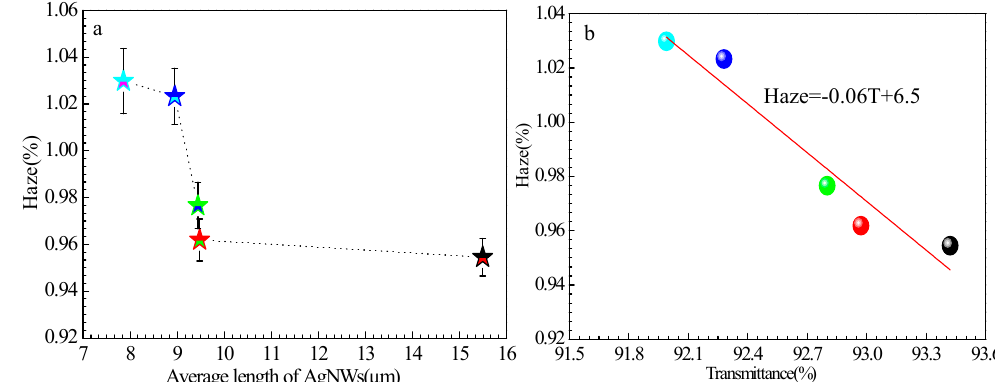
Figure 11. Relationship between the haze of AgNW-FTCFs and ( a ) the average AgNWs length and ( b ) transmittance at 550 nm.